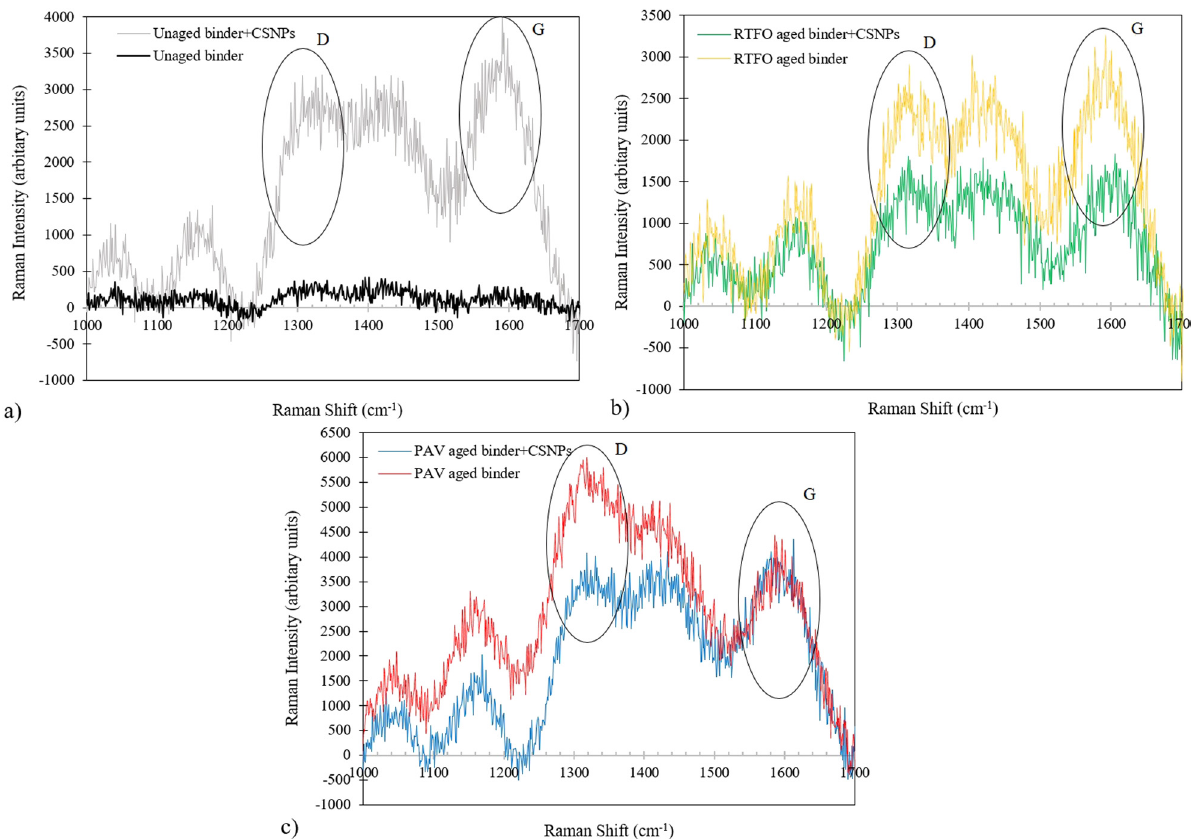
Figure 10: Raman spectra of the binder samples: ( a ) unaged, ( b ) short - term aging, and ( c ) long - term